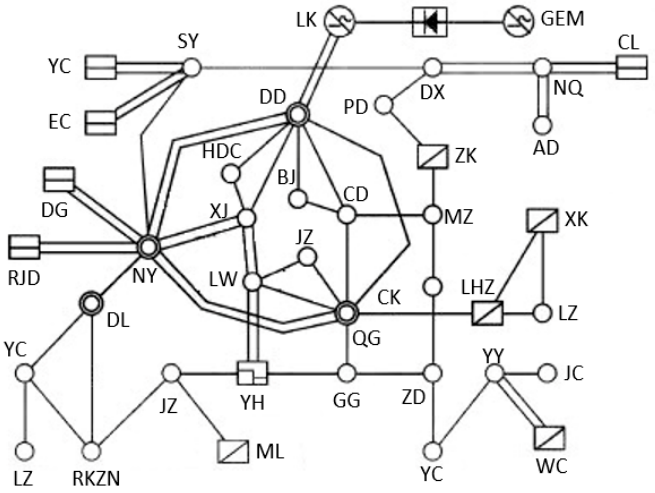
Figure 6. Geographic connection of the grid.